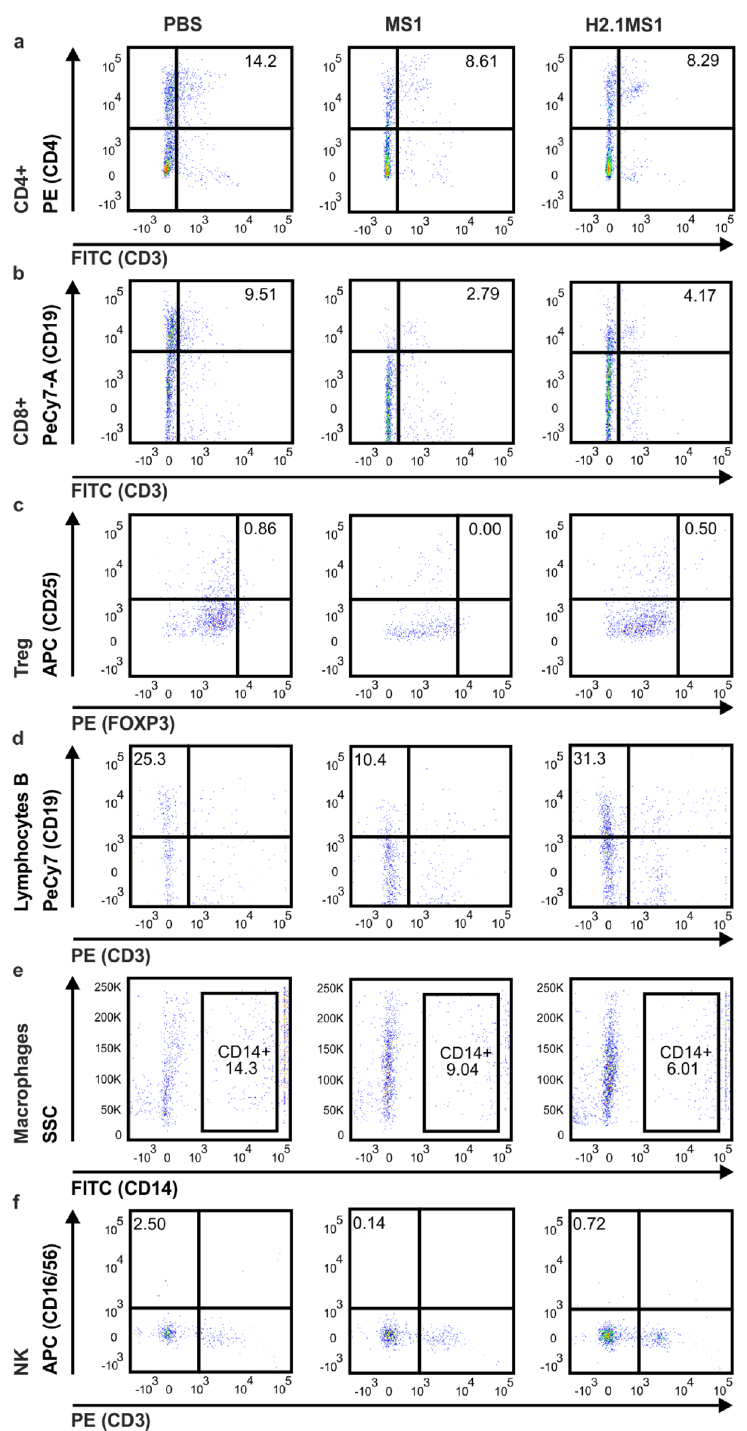
Figure 4. The phenotypes of the cells infiltrating the spheres 7 days after implantation. Mice were subcutaneously administered Matrigel loaded with PBS or MS1 or H2.1MS1 spheres, and 7 days after injection, the implants were excised and pooled among the groups; infiltrating immune cells were analyzed by flow cytometry. ( a ) CD4 + lymphocytes (CD45 + CD3 + CD4 + ), ( b ) CD8 + lymphocytes (CD45 + CD3 + CD8 +